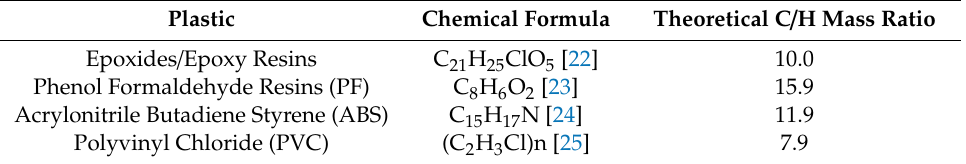
Table 3. List of potential plastics present in a